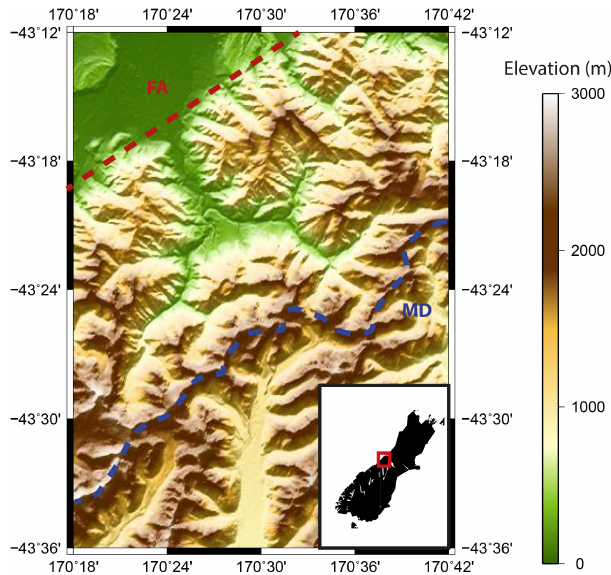
Figure 5. DEM of the Whataroa catchment in the central Southern Alps, New Zealand. AF: Alpine Fault; MD: Main